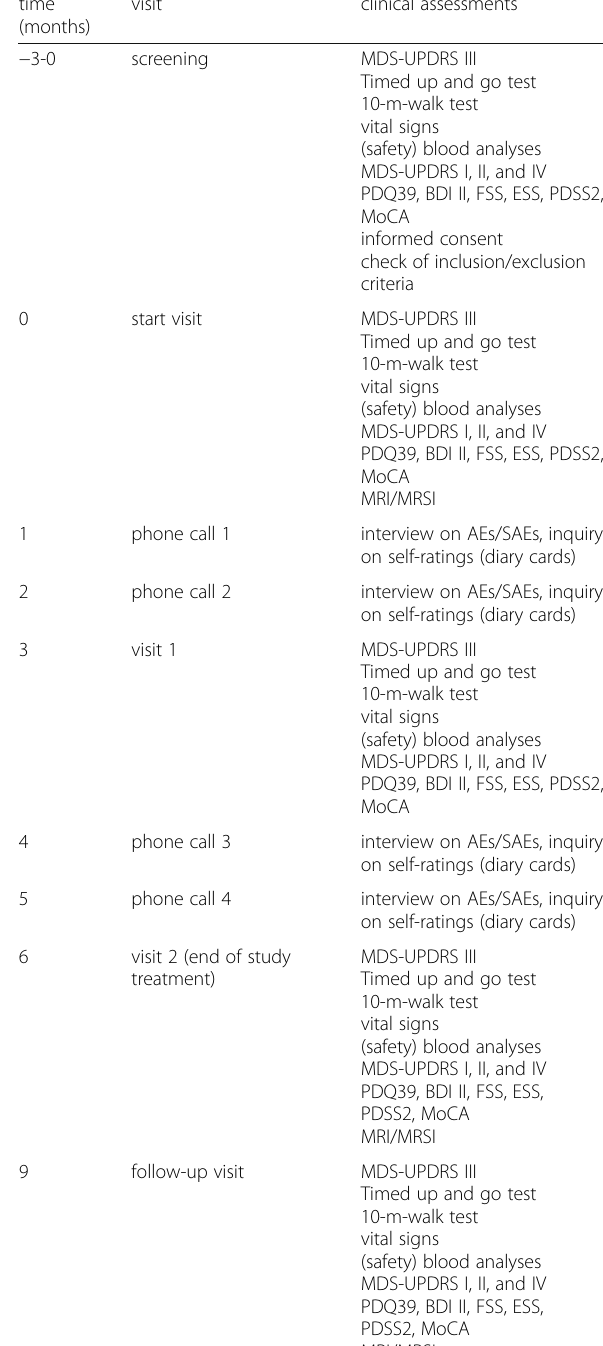
Table 1 Overview on clinical assessments for each study